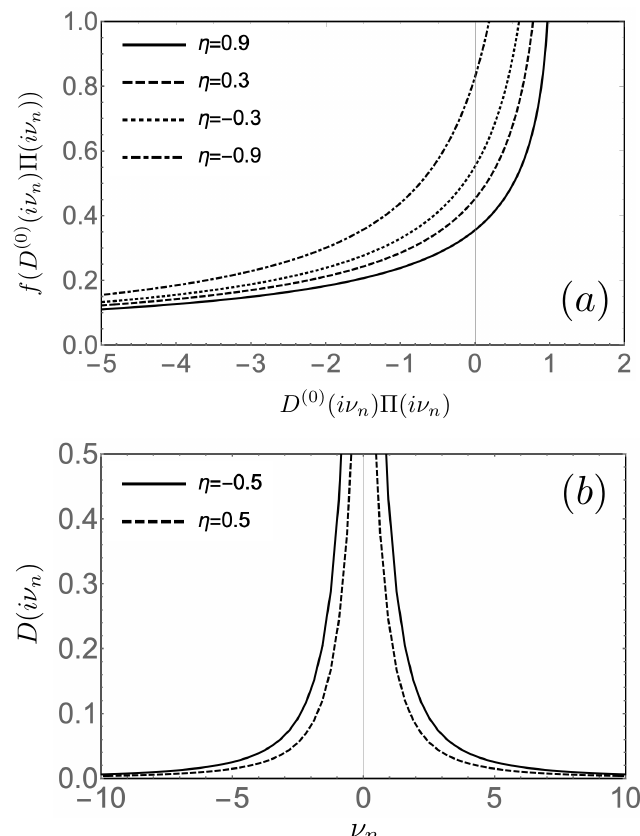
= m = 1, Figure 2: The propagator for uncondensed bosons for γ = λ max ) = D ( 0 ) ( i ν ) f ( D ( 0 ) ( i ν ) Π ( i ν )) . (a) The positive, monotonic function f D ( i ν η η has n n n n larger value for smaller η , i.e., f η ( x ) < f η (cid:48) ( x ) if η > η (cid:48) . (b) The class II bosonic prop- agator ( η < 0) is larger than the class I propagator ( η > 0) for all frequency range. ( λ ) is mostly concentrated around λ ∼ λ Since the distribution ρ η< , there is high 0 max chance to sample strong Yukawa coupling g . Hence, the bosonic propagator is ij , k more strongly enhanced by the interactions between fermions and